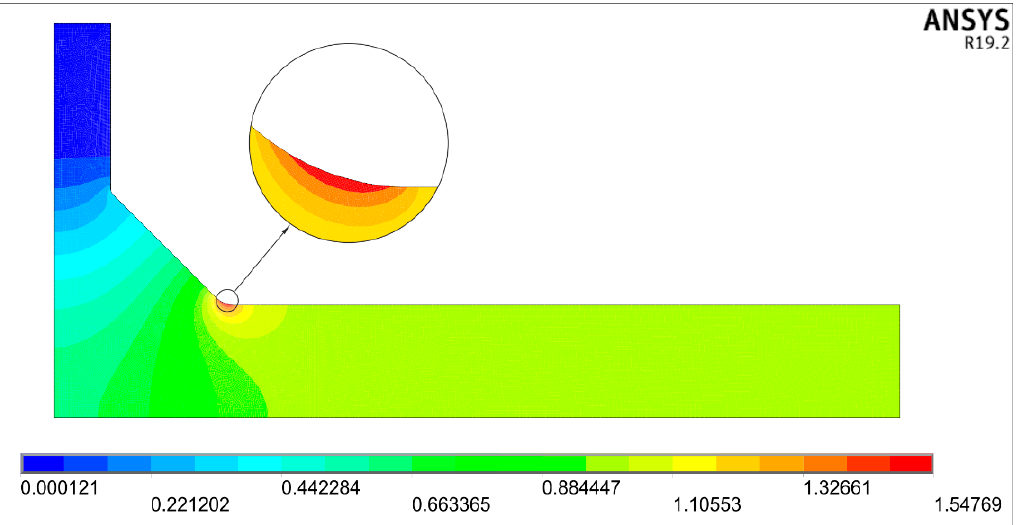
Figure 6. Heat flux q distribution, interpreted as shearing stress τ for τ s = 1 MPa, while θ = 45°, X = 0.25, Y = 0.415 and T / t = 1.